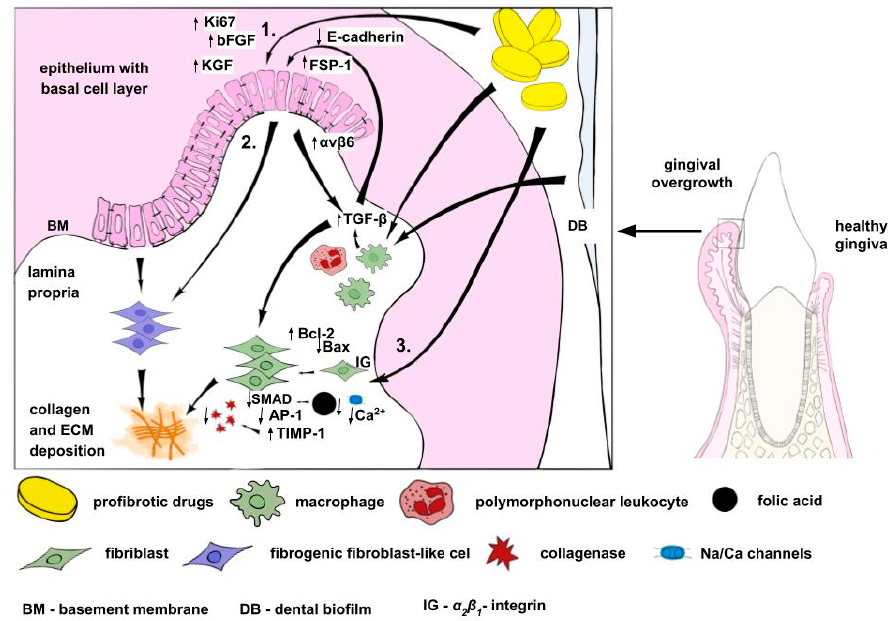
Figure 1. Pathophysiology of drug-induced gingival overgrowth. (1) Profibrotic drugs